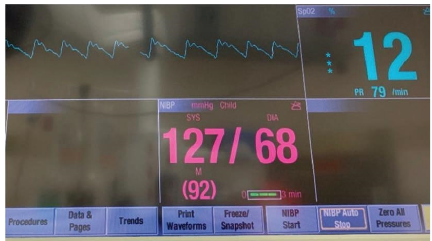
Figure 3: A standard pulse oximetry reading on room air.